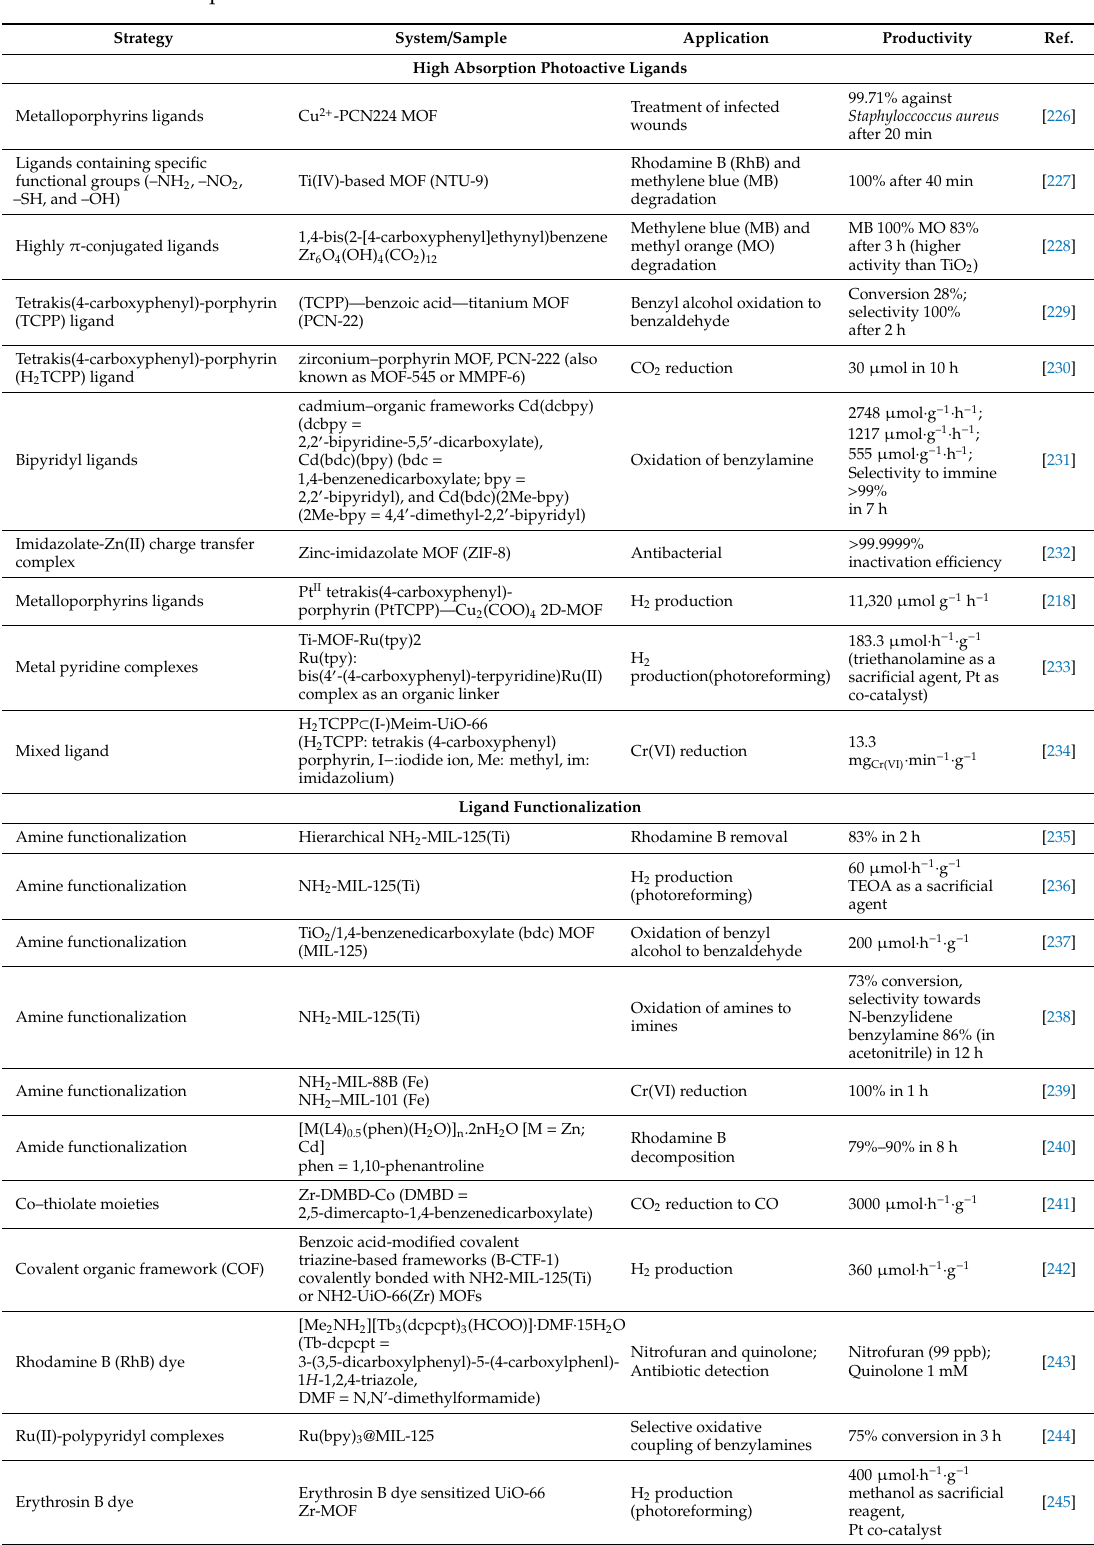
Table 5. Strategies to improve metal-organic frameworks (MOFs) photocatalytic activity and performance data of obtained systems under visible irradiation or solar light irradiation. The best results achieved in each work are